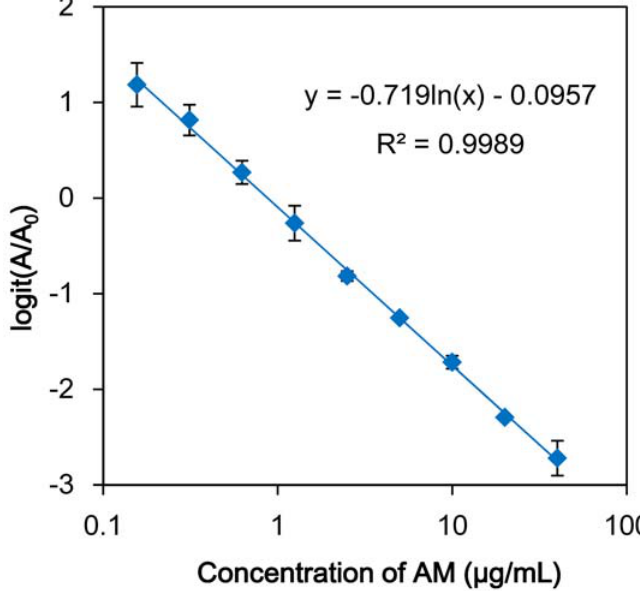
Figure 3. Standard curves for the inhibition by AM in an indirect competitive ELISA using the recombinant Fab. Various concentrations of AM was incubated with the recombinant Fab (0.5 µg/mL) against AM in a 96-well immunoplate precoated with AS-OVA (1